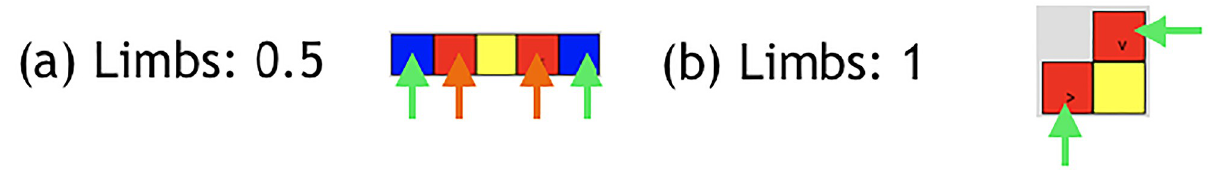
Fig 8. Morphology (a) has four modules that could be extremities (considering the limit determined by the size of the morphology), but only the two indicated by green arrows are; (b) has the maximum number of extremities it could have.